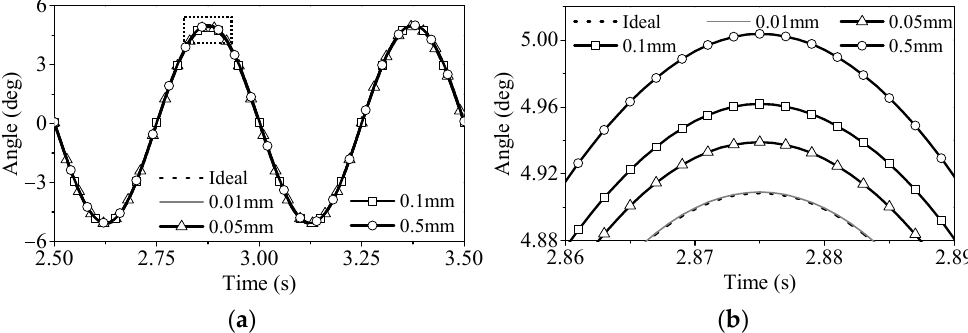
Figure 7. Angle of the rigid system with different clearance sizes: ( a ) angle; ( b ) partial enlarged drawing.